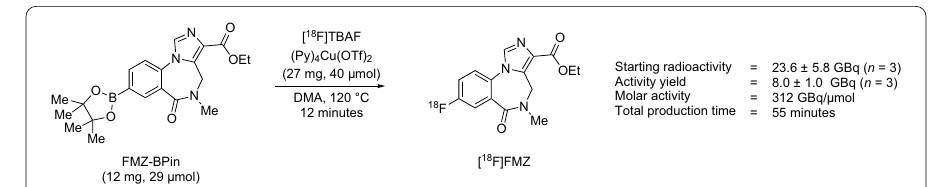
Fig. 3 Optimised automation conditions for the production of [ 18 F]FMZ